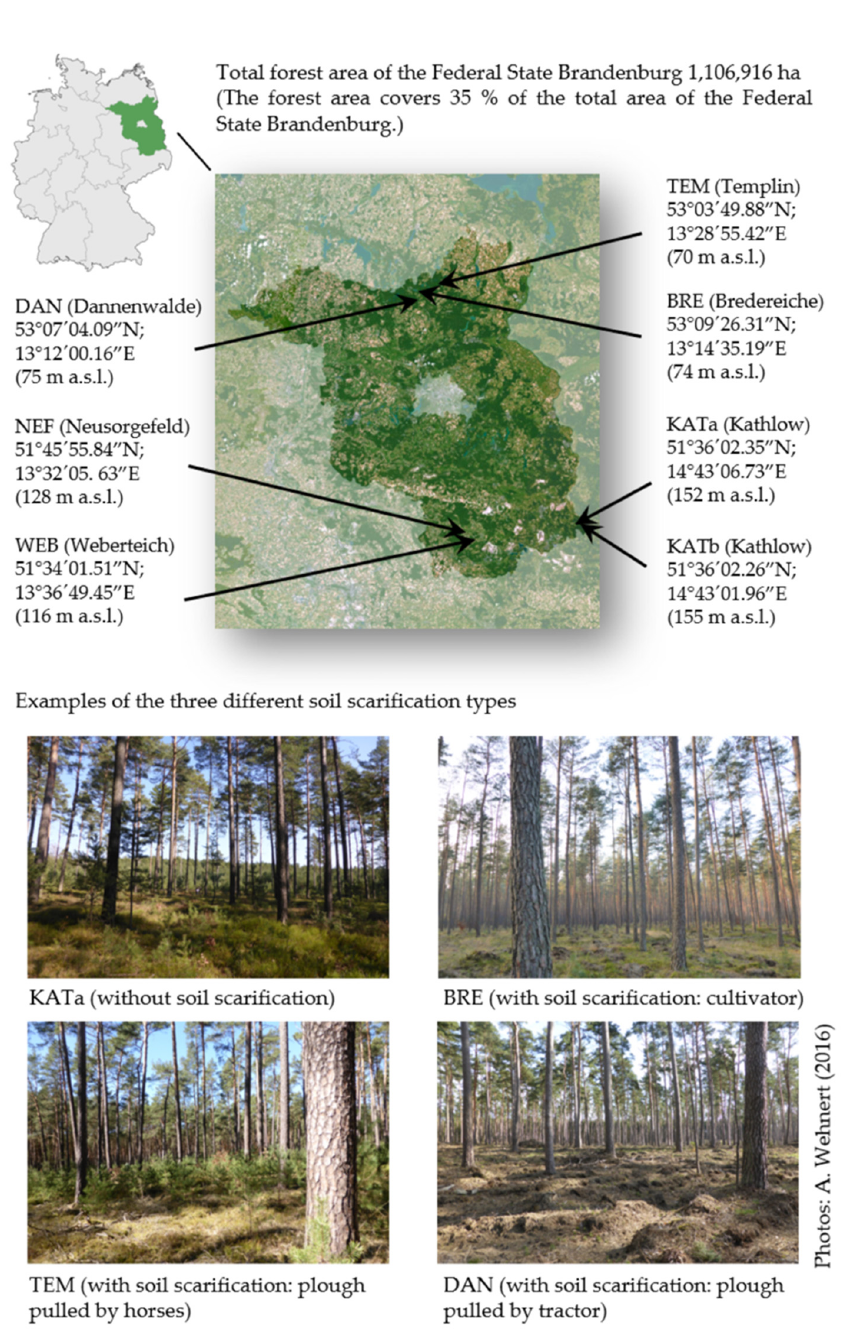
Figure 1. Locations of the study sites in the Federal State Brandenburg (Germany) and photos showing the study sites with different soil scarification types.